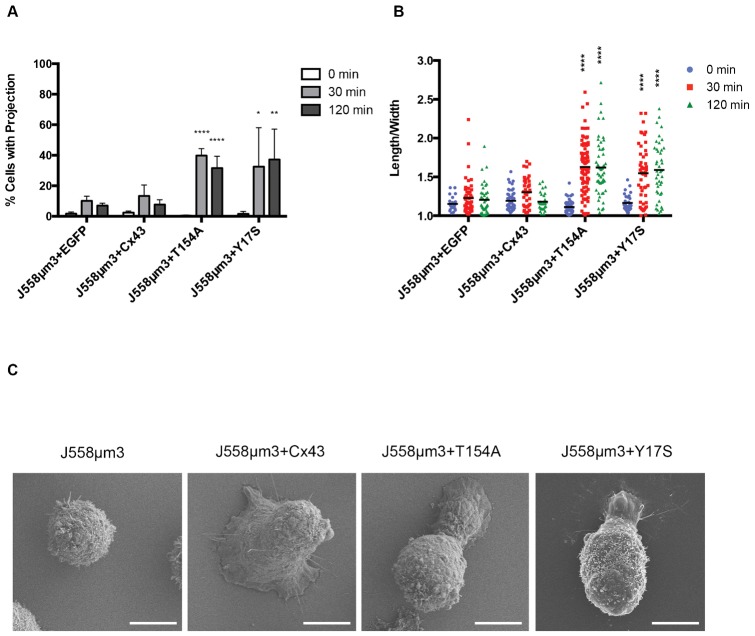
Expression of Cx43 mutant T154A resulted in non-radial spreading and formation of protrusions in J558µm3 cells spreading in response to BCR signaling.(A) Mean percentage of cells with protrusions during BCR-induced cell spreading. Protrusions were defined as cellular extensions with lengths equal to at least half the cell diameter or greater. Asterix denotes significant difference between later time-points compared to 0 min as determined by P-value: *<0.05; **<0.005; ****>0.0001, n = 100. (B) Quantification of roundness by length/width where 1  =  round and >1 indicates non-radial spreading and the formation of protrusions. Asterix denotes significant difference between later time-points compared to 0 min as determined by P-value: ****<0.0001, n = 100. (C) SEM of spreading J558µm3 cells expressing the given constructs. Scale bars: 5 µm.